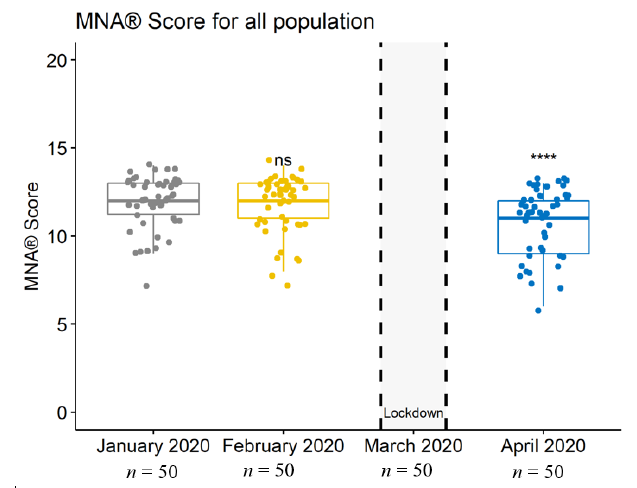
Figure 3. Boxplot depicting the population’s MNA ® score at each data collection. ns, no signifi- cant difference between January 2020 and April 2020; ****, highly significant difference between